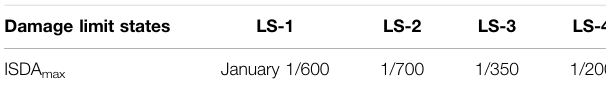
TABLE 6 | Classi fi cation of damage limit states.